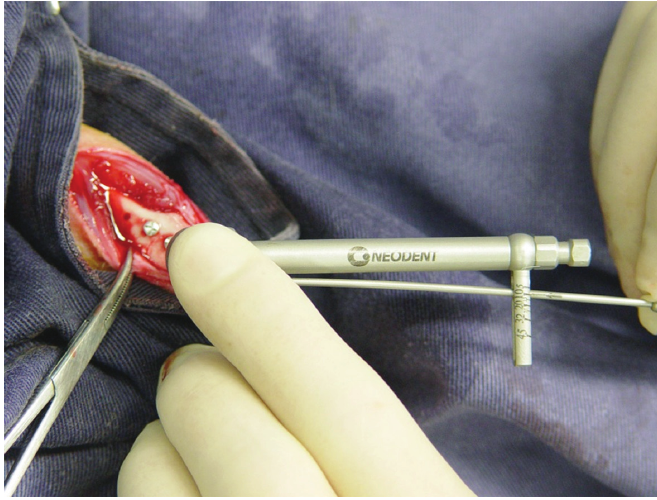
FIGURE 2 - Application of the insertion torque values on the